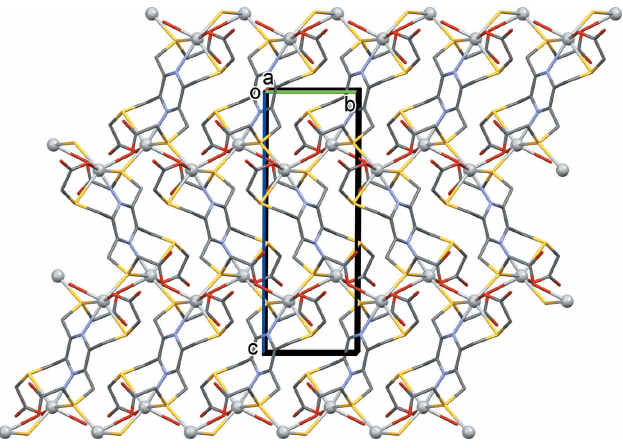
Figure 2 A view along the a -axis of the network of the silver complex dianions in compound I . The silver atoms are shown as silver balls. For clarity, the potassium ions, the disordered water molecules, and the C-bound H atoms have been omitted.